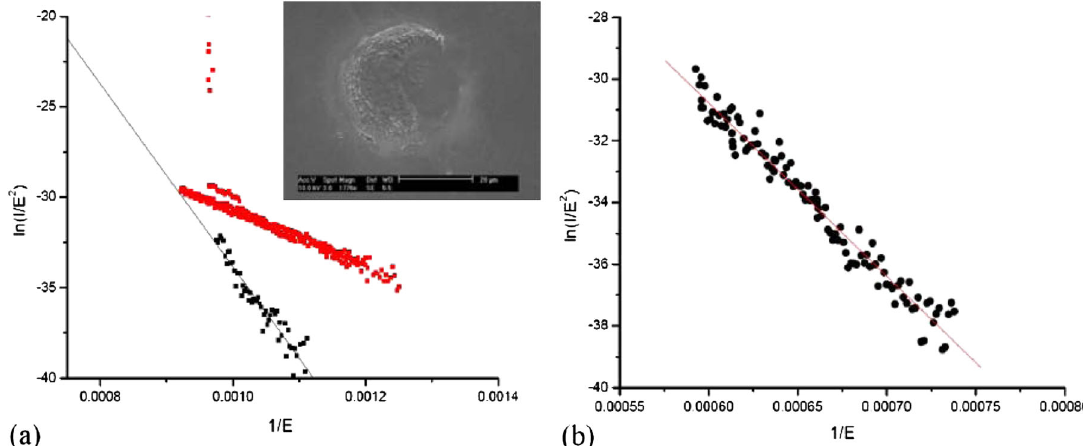
FIG. 6. (Color) I-V curves as FN plots locally measured on sample (a) SCNb4, showing the creation of an emitter by a microdischarge with resulting surface damage (inset SEM image) and (b) SCNb7, showing intrinsic field emission of Nb ( (cid:3) ¼ 1 , (cid:1) ¼ 4 eV ).